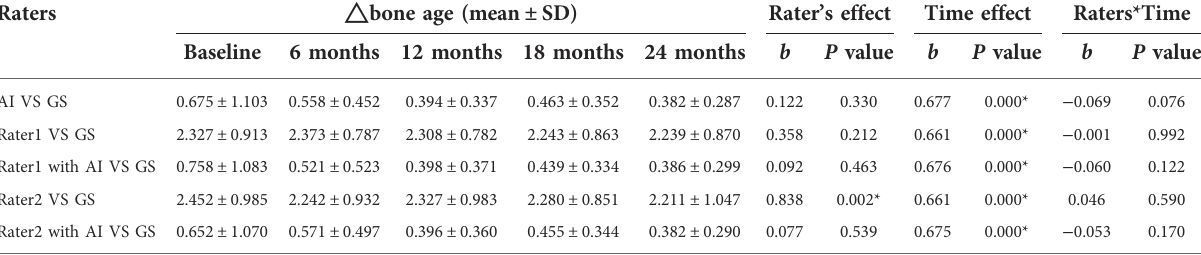
TABLE 4 Raters effect in bone age evaluation in the course of treatment from analysis using mixed linear model.